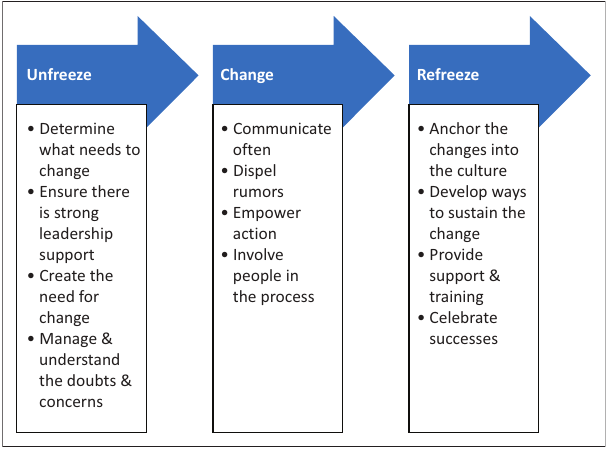
FIGURE 1: Lewin’s change